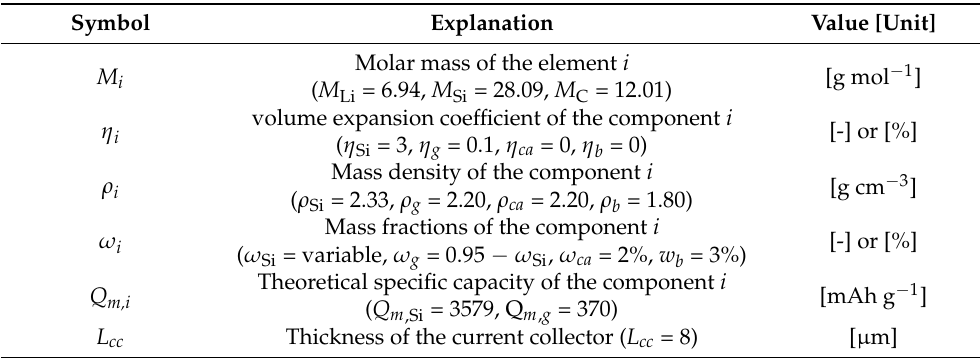
Table 1. Nomenclature and physical properties used in this